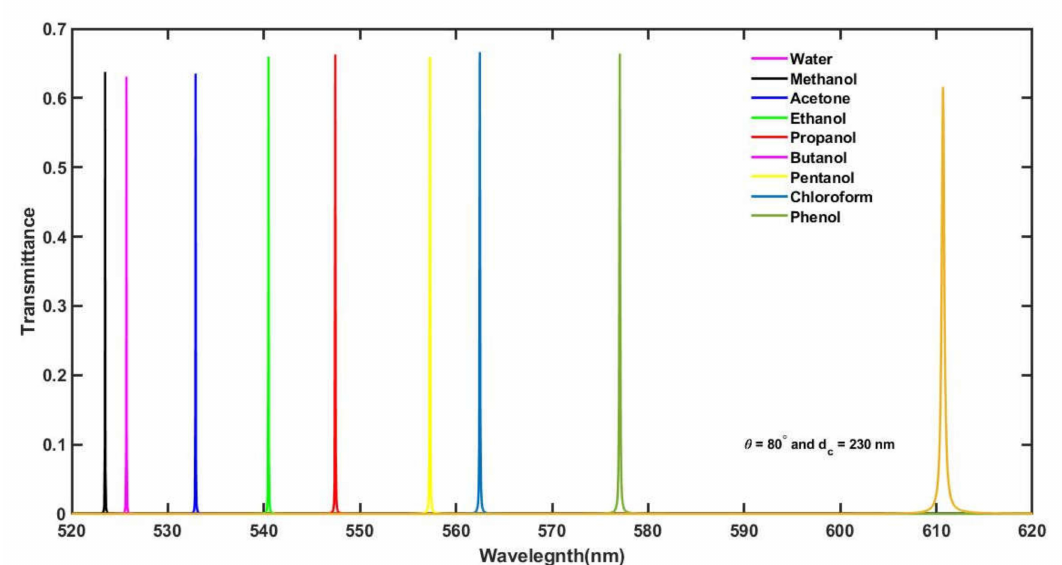
Figure 8. The transmittance spectra of the proposed bio-alcohol sensor loaded separately with water samples containing methanol, acetone, ethanol, propanol, butanol, pentanol, chloroform and phenol, each of a concentration of 30% with respect to the pure water sample at θ = 80 ◦ and d c = 230